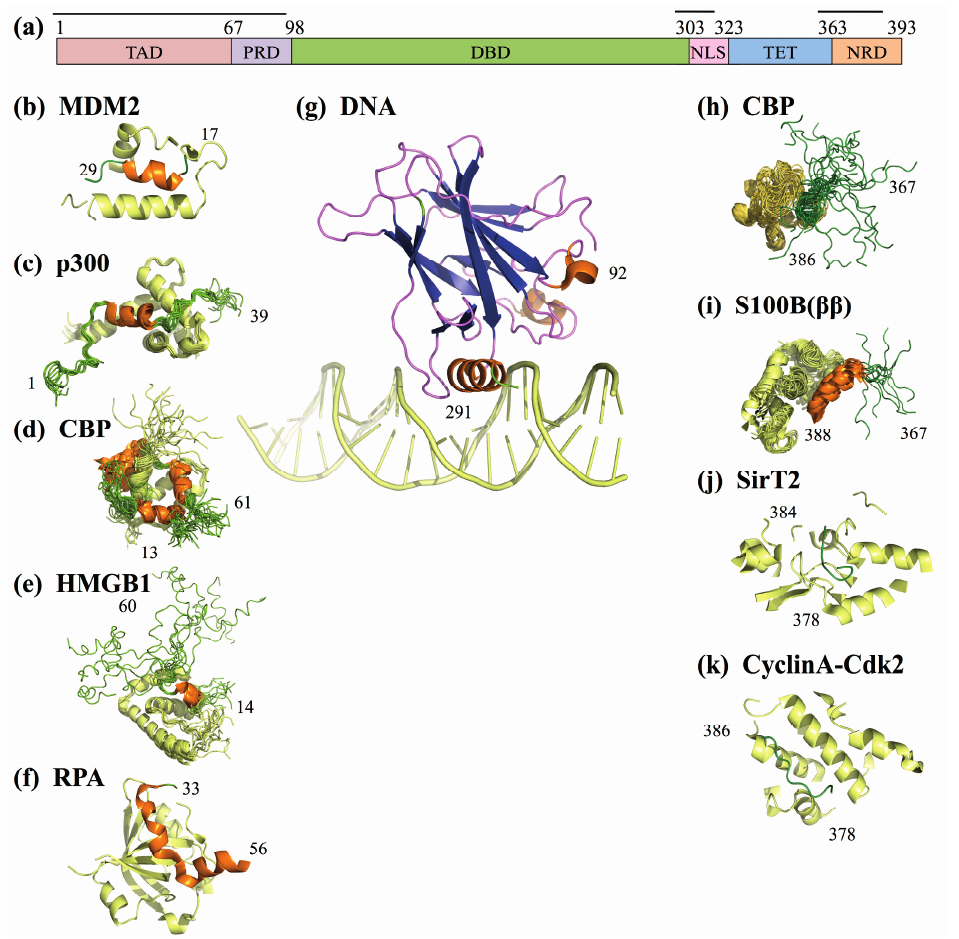
Figure 5. p53 domains and interactions. ( a ) The primary sequence of p53, colored according to domains. Horizontal lines above sequence indicate disordered domains in the monomer; ( b – k ) A PDB structure/model for each p53 region discussed in the paper is shown beneath its corresponding domain in ( a ). Ordered regions of p53 are shown in orange (helices), blue (sheets), and purple (loops); IDRs are shown in green; DNA/regions of binding partners within 15 Å of p53 are shown in yellow. Multiple potential structures are shown superimposed for NMR ensembles, whereas a single structure is shown for crystal structures. Indices of first and last p53 residues included in each structure are provided. In order ( b – k ), the PDB IDs of the models shown are: 1ycr, 2k8f, 2l14,